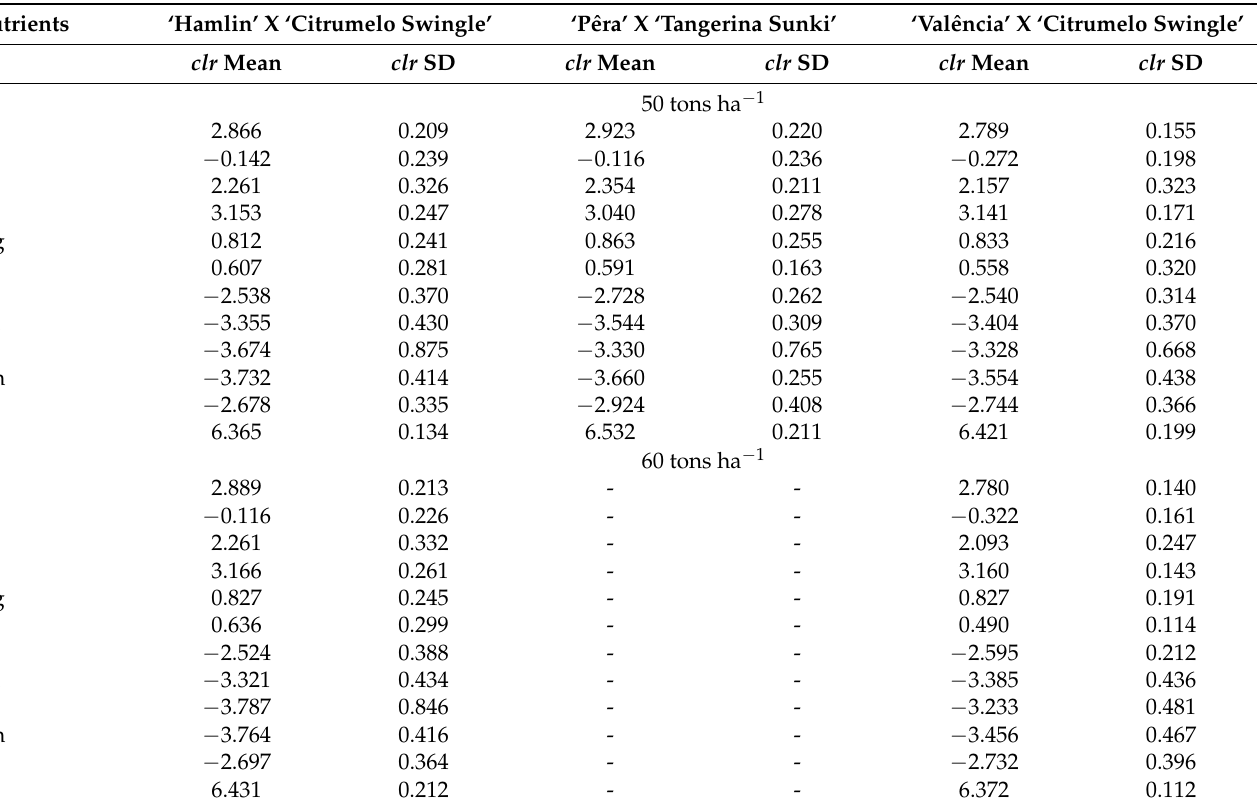
Table 8. Nutrient standards as clr mean and standard deviation (SD) of ‘Hamlin’ X ‘Citrumelo Swingle’, ‘P ê ra’ X ‘Tangerina Sunki’, and ‘Val ê ncia’ X ‘Citrumelo Swingle’ TN specimens at a yield cutoff of 50 tons ha − 1